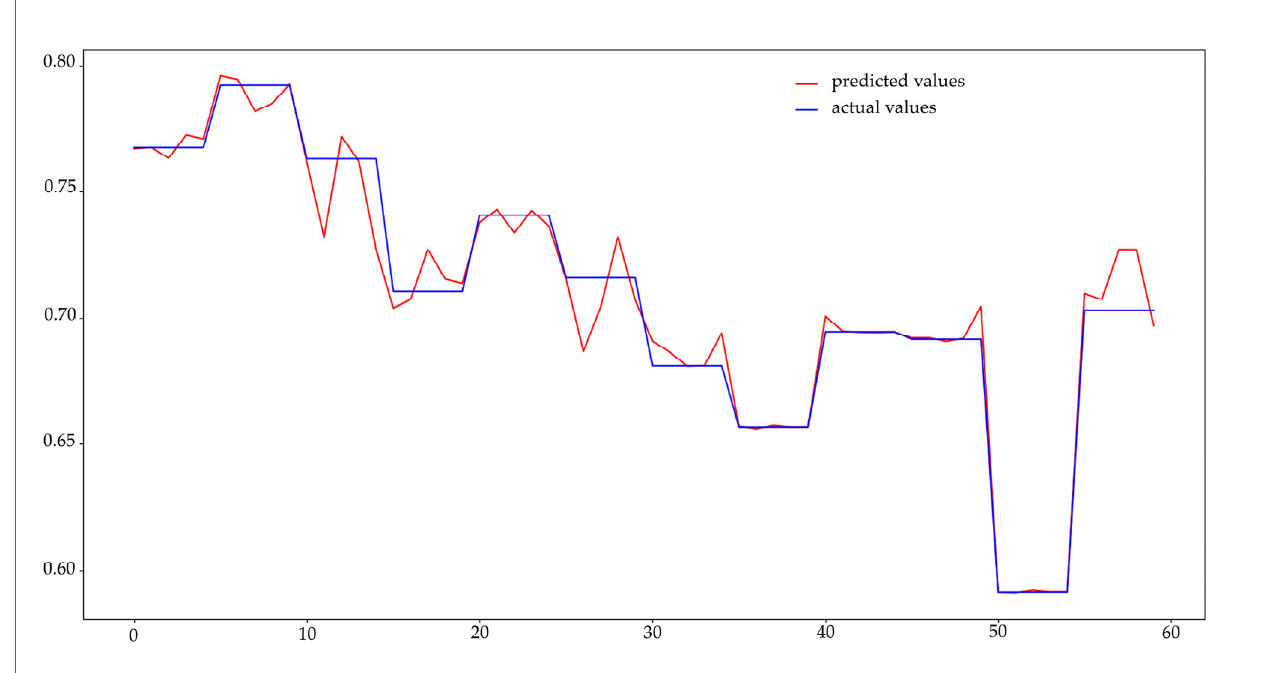
Figure 12. Actual values and values predicted by the ANFIS model—Gaussian function.